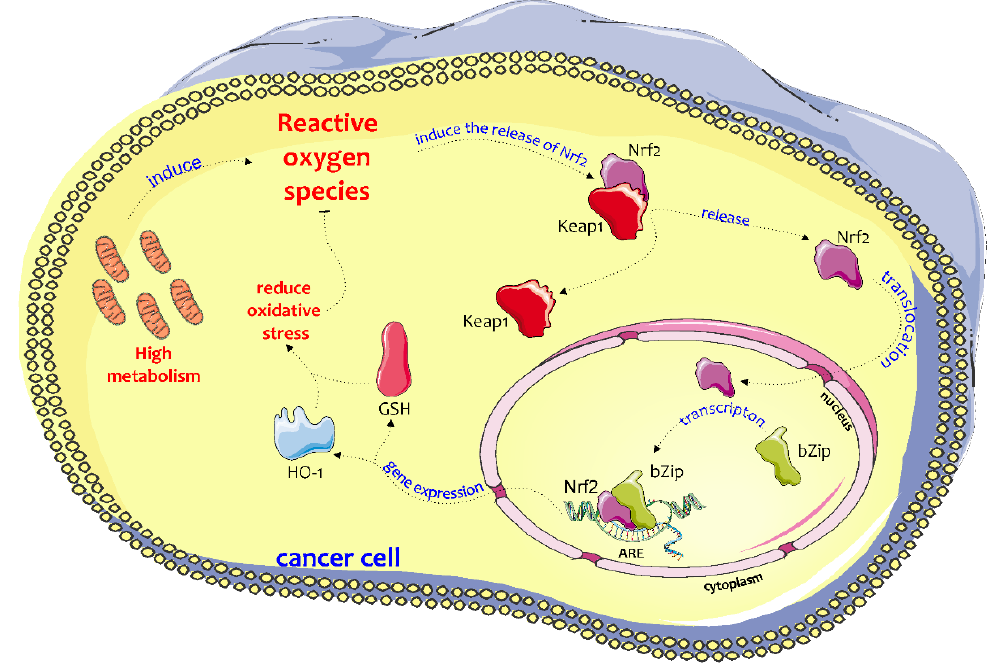
Figure1. BiochemicalpathwaysofNRF2activationincancercells. Elevatedmetabolicrateisresponsible